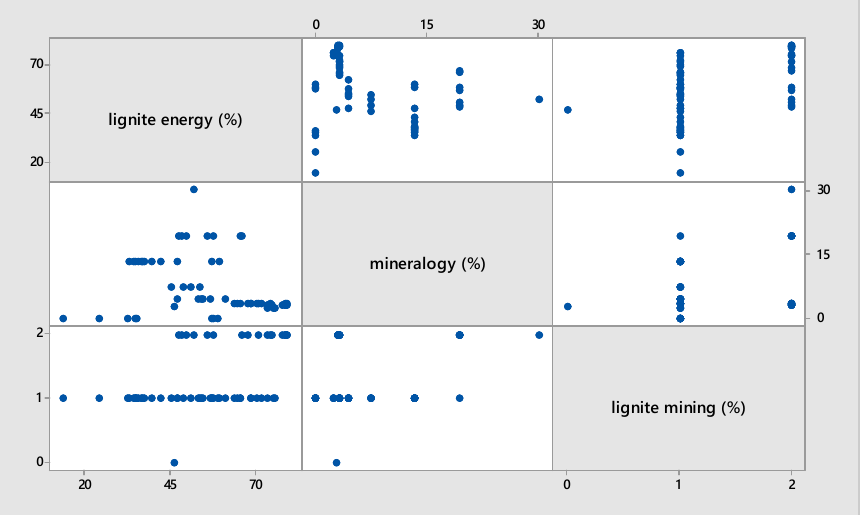
Figure 4. Matrix plot of electricity generated by lignite (%) in the interconnected system, the content of mineralogy (%) and content of lignite mining (%) in the geosciences textbooks.